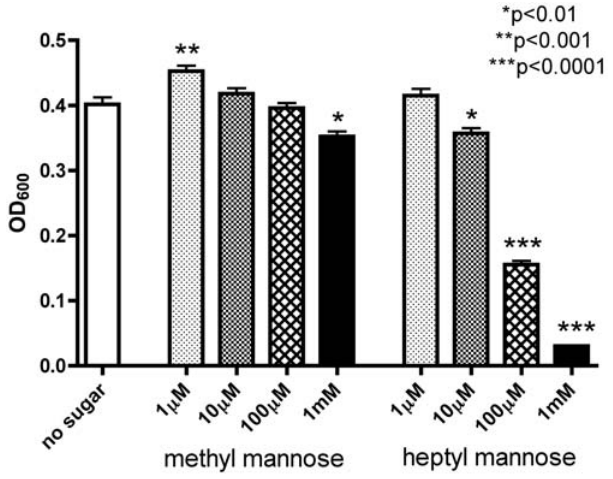
Figure 9. Biofilm formation in the presence of methyl or heptyl a - D -mannose . Standard biofilm assays showed a great reduction of UTI89 biofilm formation in the presence of 100 m M and 1 mM HM (p , 0.0001) and a significant increase (p , 0.01) in the presence of 1 mM MM.